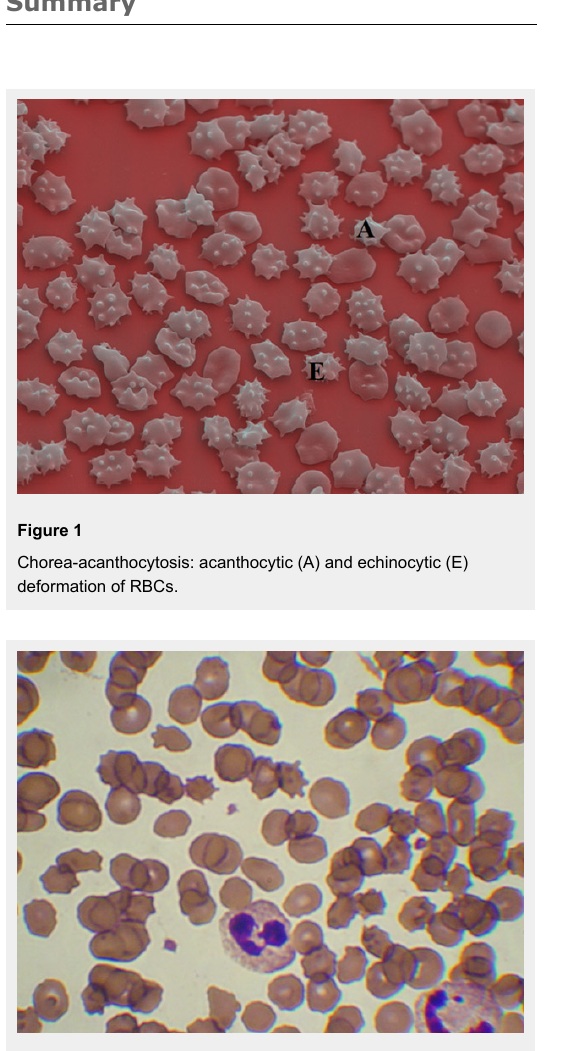
Figure 2 ChAc: peripheral blood smear: differentiating